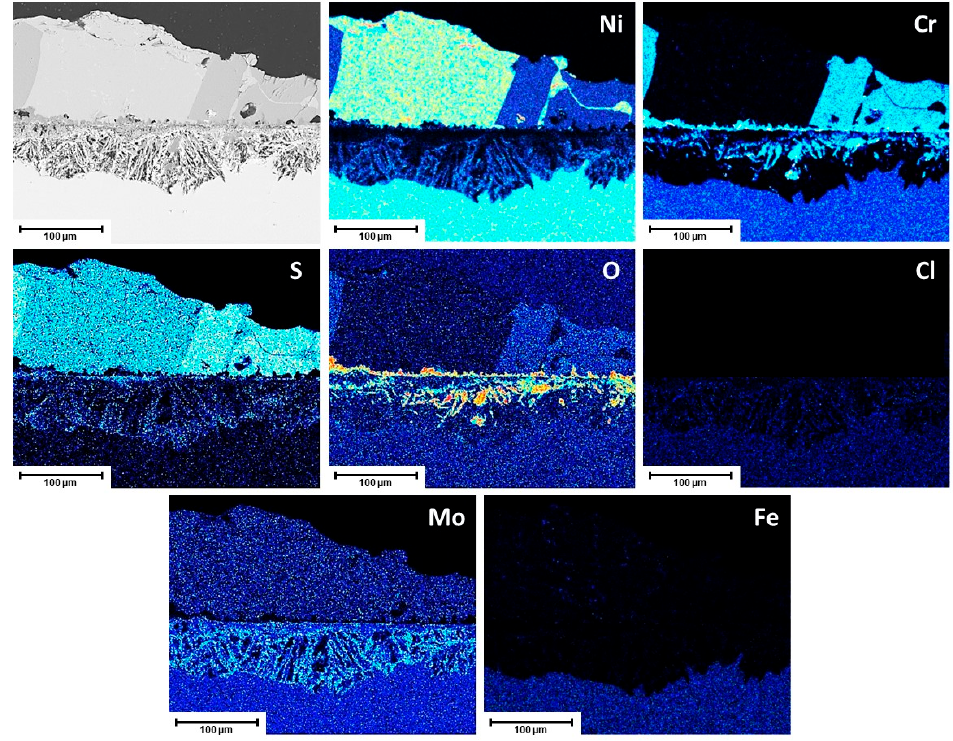
Figure 5. N10276 after 240 h at 680 °C. SEM and EDX element mapping of the cross section. At 480 ◦ C, the grown corrosion layer reaches a thickness of around 20 µ m and the EDX mapping reveals a layer of nickel sulfide containing some iron, which formed